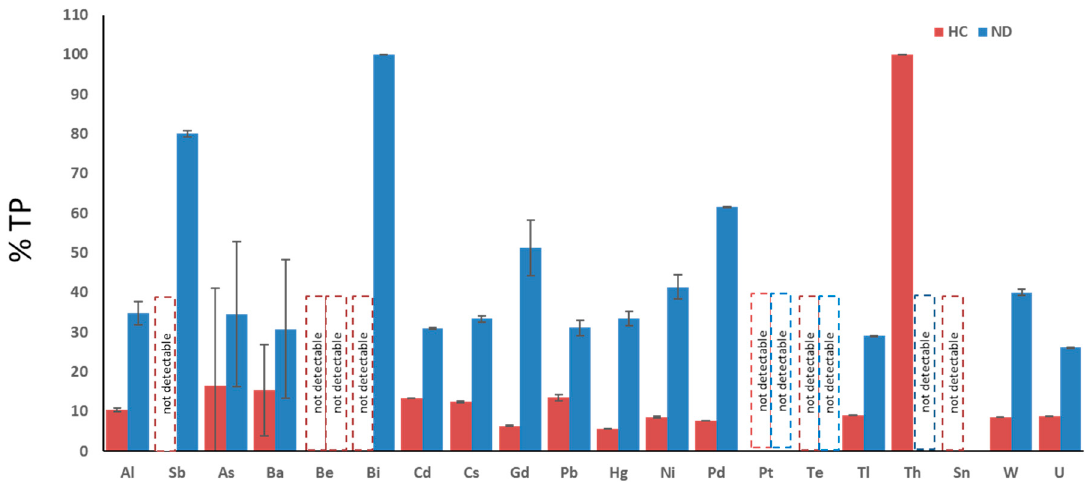
Figure 2. Percentage of total patients (TP) affected by toxic-metal burdens (mean ± SEM). ND = patients affected by neurodegenerative diseases. HC = healthy controls. Aluminum (Al), antimony (Sb), arsenicum (As), barium (Ba), beryllium (Be), bismuth (Bi), cadmium (Cd), cesium (Cs), gadolinium (Gd), lead (Pb), mercury (Hg), nickel (Ni), palladium (Pd), platinum (Pt), tellurium (Te), thallium (Tl), thorium (Th), tin (Sn), tungsten (W), and uranium (U).